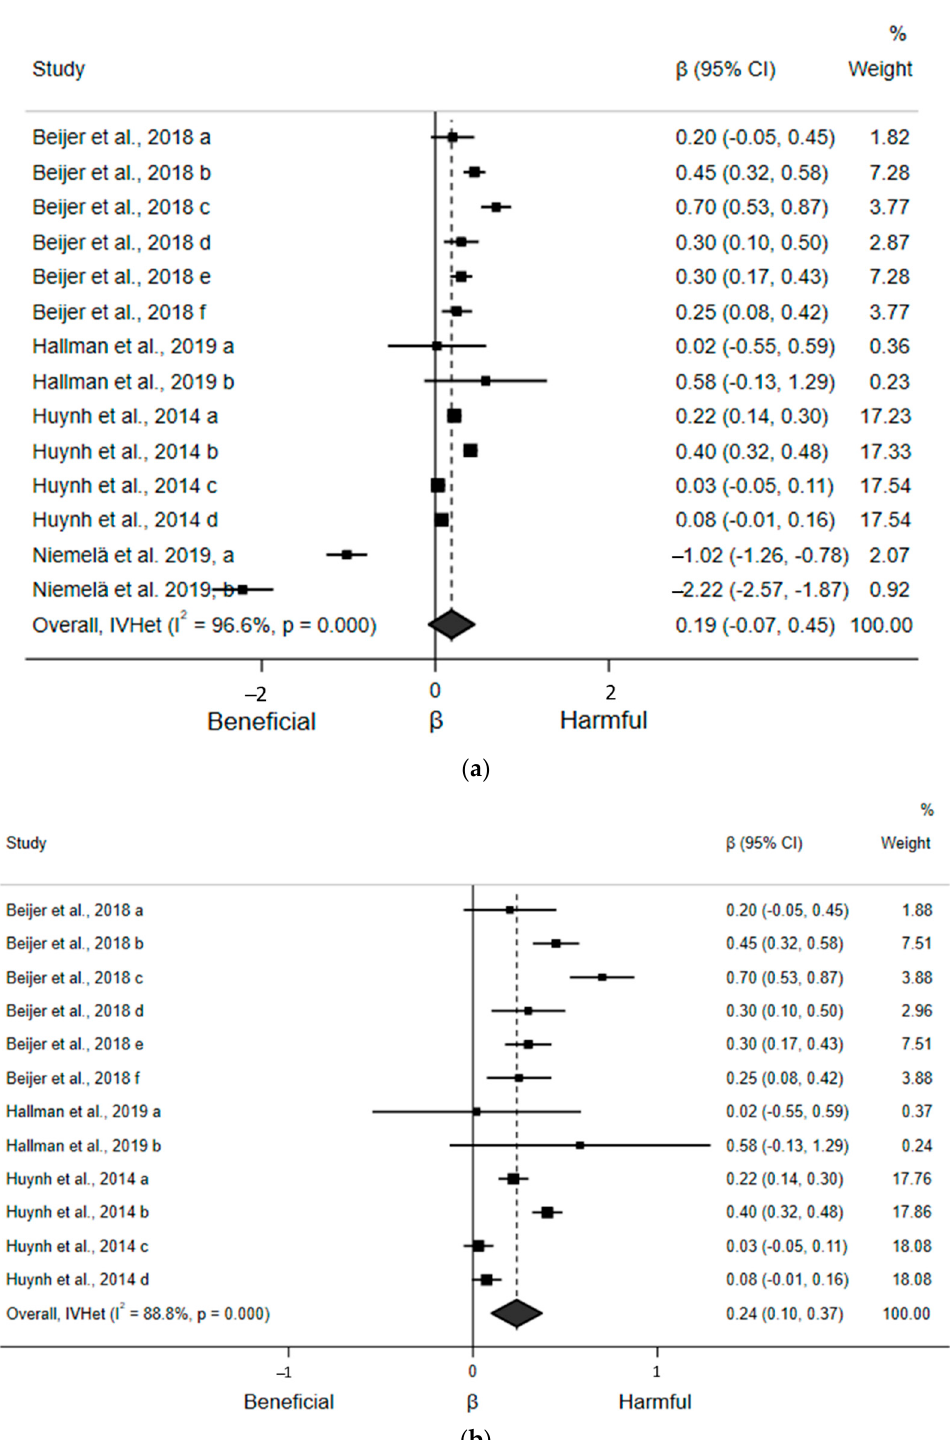
Figure 2. Forest plots of articles examining the association between ST and HR. ( a ) Association between ST (hours/day) and HR (beats/minute) including all articles. ( b ) Association between ST (hours/day) and HR (beats/minute) after excluding the high influence article [25].